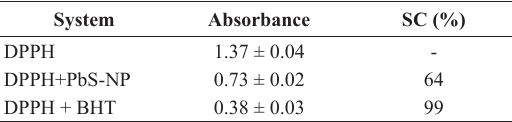
) of PMMA in function of v